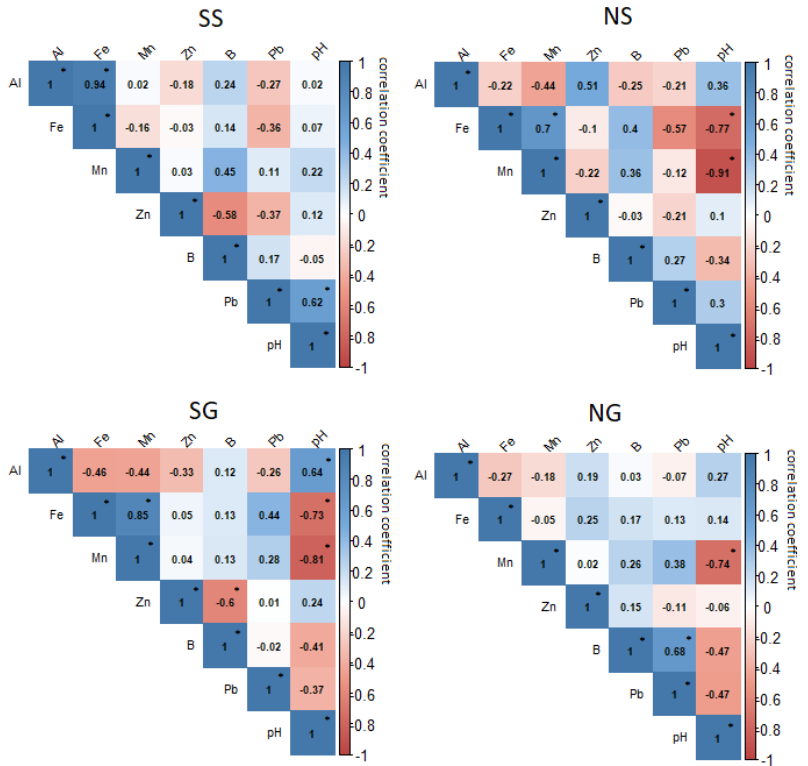
Figure 3. Correlation matrices for the different minor elements and pH, analysed by profile (SS, NS, SG, and NG). The values in the matrices are the Pearson correlation coefficients, calculated from the 11 soil characteristics obtained from each profile. Red cells—negative relationships; blue cells—positive correlations; asterisks––statistically significant correlations ( p < 0.05).